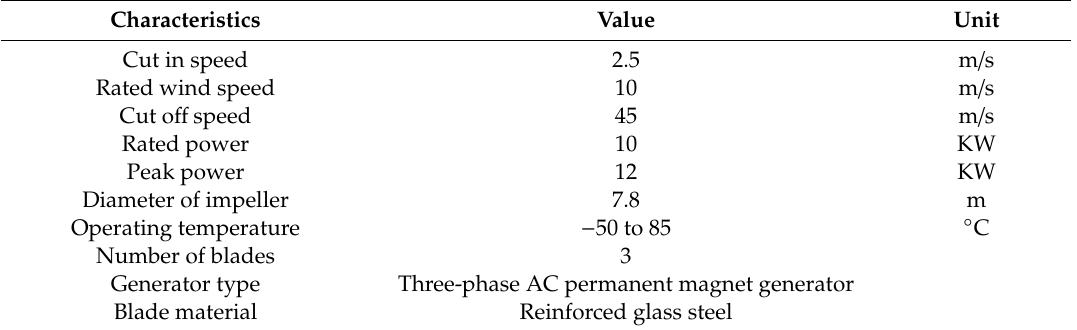
Table 4. Key specifications of the wind